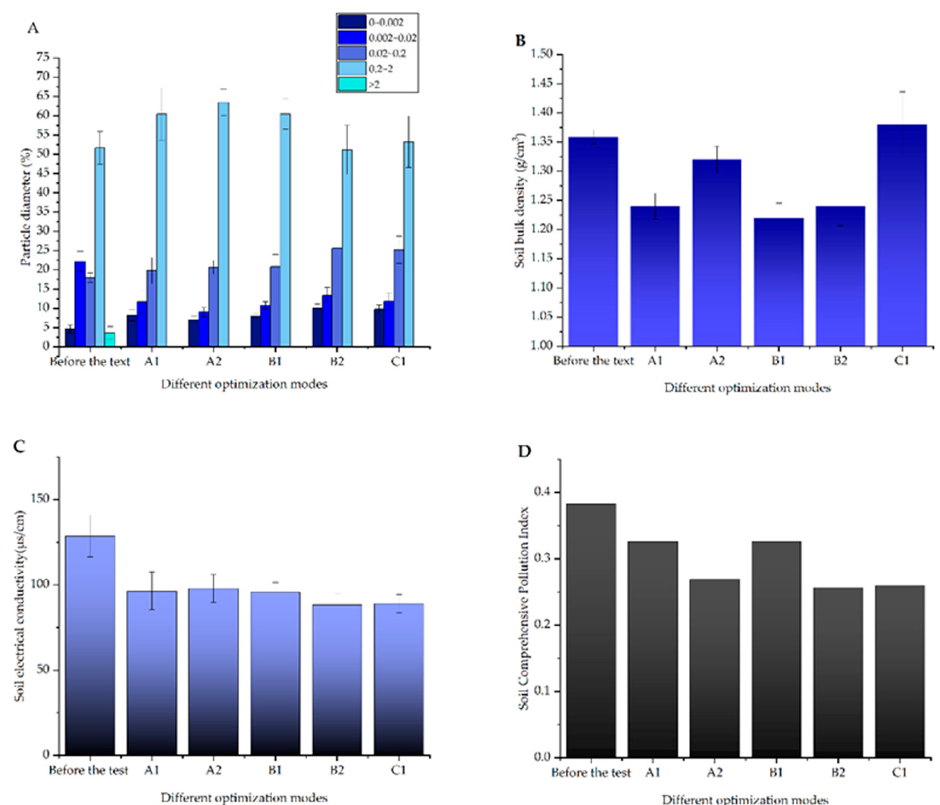
Figure 2. Effects of different optimization models based on woody peat on soil physical and chemical properties. ( A ) Soil particle size distribution. ( B ) Soil electrical conductivity. ( C ) Soil electrical conductivity. ( D ) Comprehensive soil pollution index.